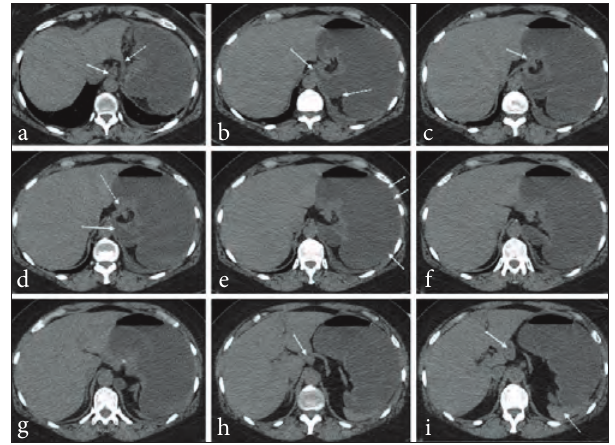
Fig. 1. Axial series of images through the abnormally orientated, distended stomach, progressing caudally from image A to I. (a) Distal oesophagus (solid arrow), gastrohepatic ligament (broken arrow). (b)GO junction (solid arrow), gastric fold (broken arrow). (c) Pylorus (solid arrow). (d) GO junction/ gastric cardia (solid arrow), gastroduodenal junction (broken arrow). The GO junction and gastroduodenal junction are closely approximated. (e) Greater curvature of the stomach (arrows). The greater and lesser curvatures maintain their normal relationship. (f) GO junction (arrow). (g) Gastric suspensory ligament (arrow). (h) First part of the duodenum (arrow), hepatoduodenal ligament. (i) Duodenum (solid arrow), displaced spleen (broken